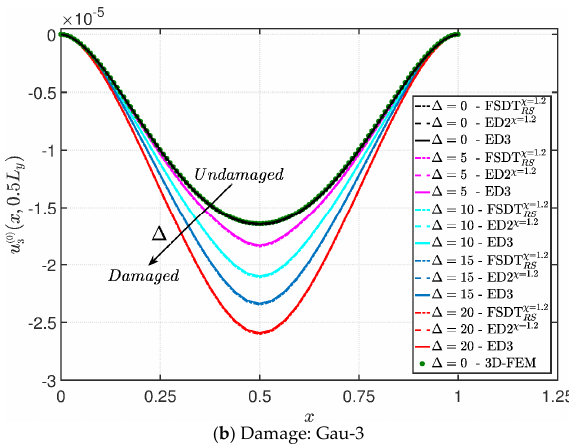
Figure 6. Evaluation of the central vertical displacement profile [m] for the completely clamped boundary conditions (CCCC) isotropic square plate varying the mechanical parameters of the damage: ( a ) Gau-2; ( b ) Gau-3. The results are obtained by means of several Higher-order Shear Deformation Theories (HSDTs).